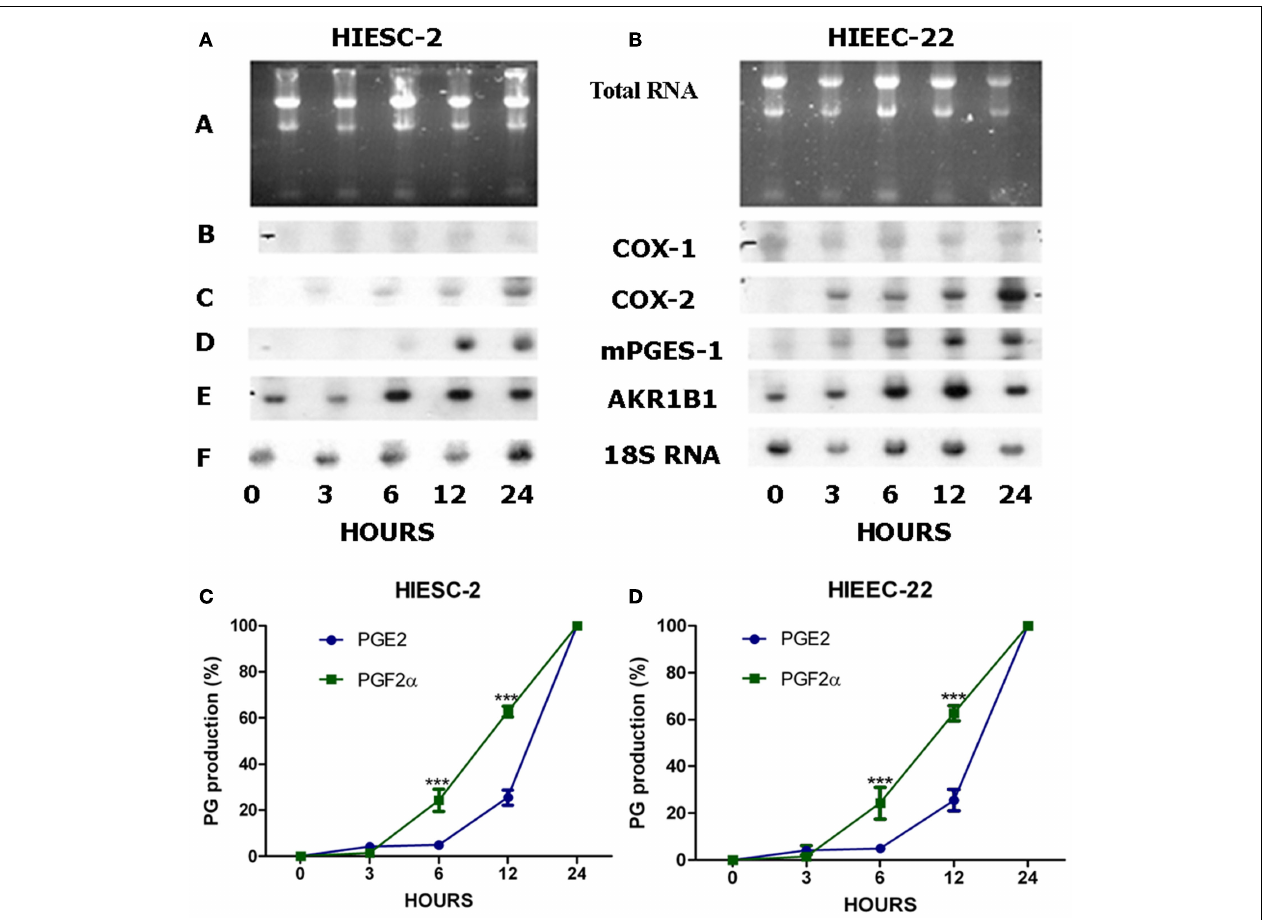
to 24h. Northern Blots analysis (A,B) was used for detection of AKR1B1, COX-1/-2, mPGES-1 mRNAs expression.The production of PGs was evaluated as a function of time in stromal (C) and epithelial (D) endometrial cells where stimulation ofPGF2 α precedes that of PGE2 ( P <